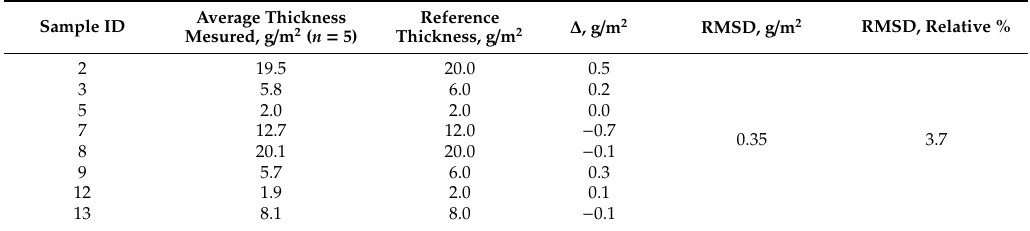
Table 2. Accuracy of Al thickness coating measurement ( n = 8, m =